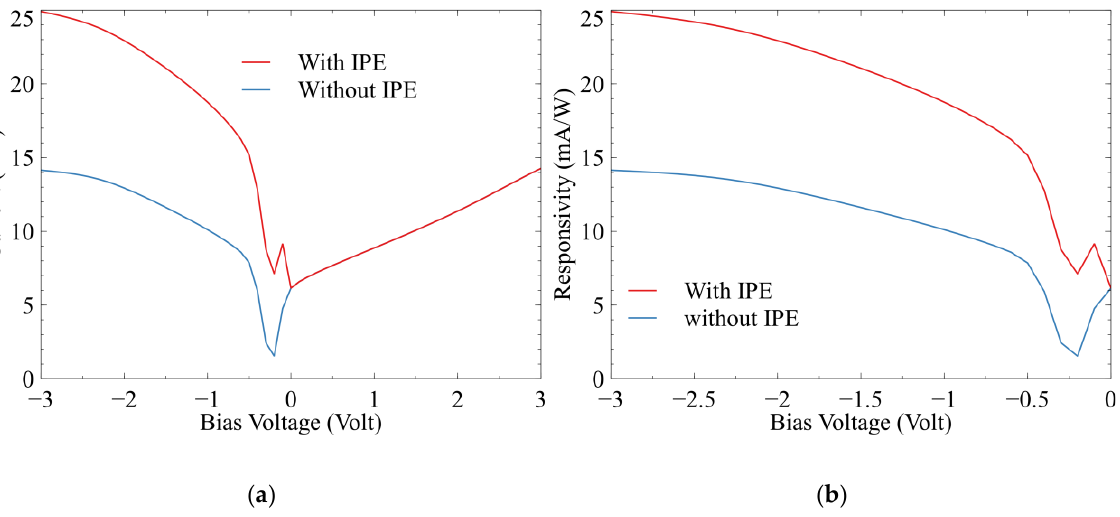
Figure 8. Electrical characteristic with IPE effect included. ( a ) IV characteristic of the device with light current for photocurrent without IPE and photocurrent with IPE, ( b ) responsivity comparison with and without IPE effect.